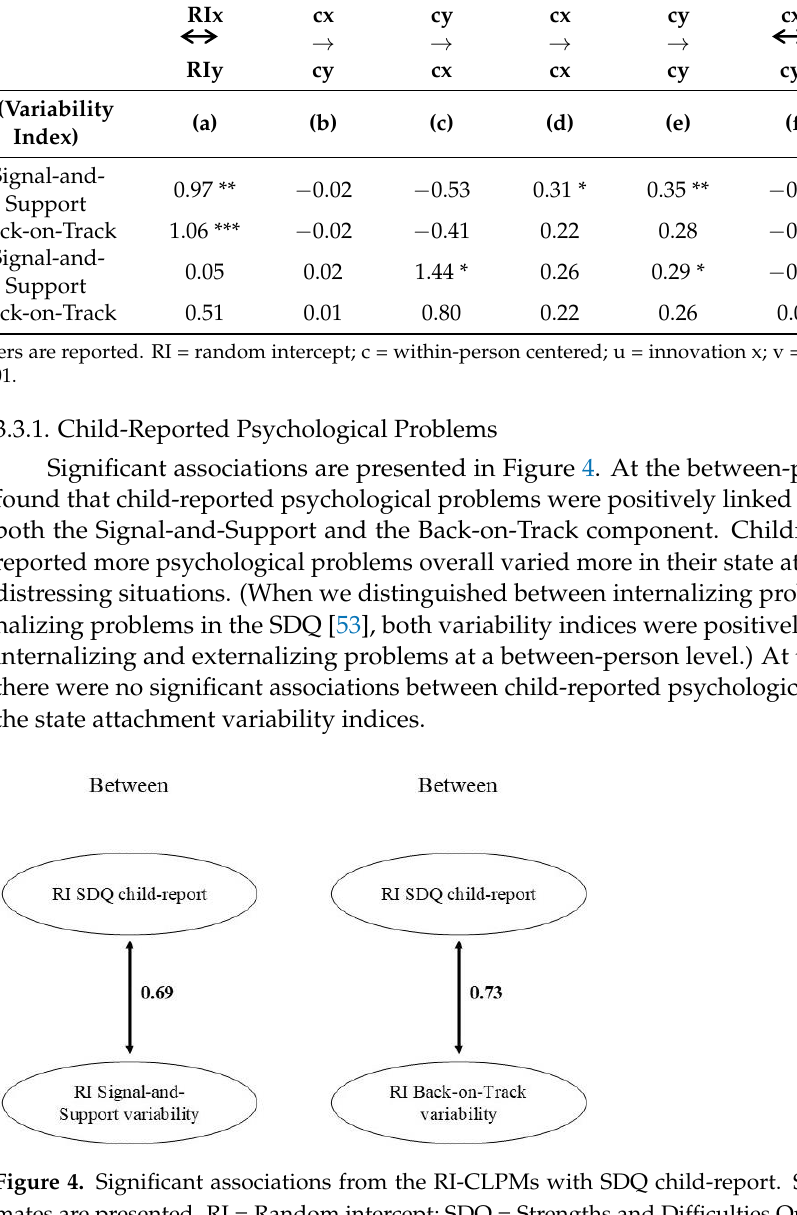
Table 7. RI-CLPM results with Psychological problems.